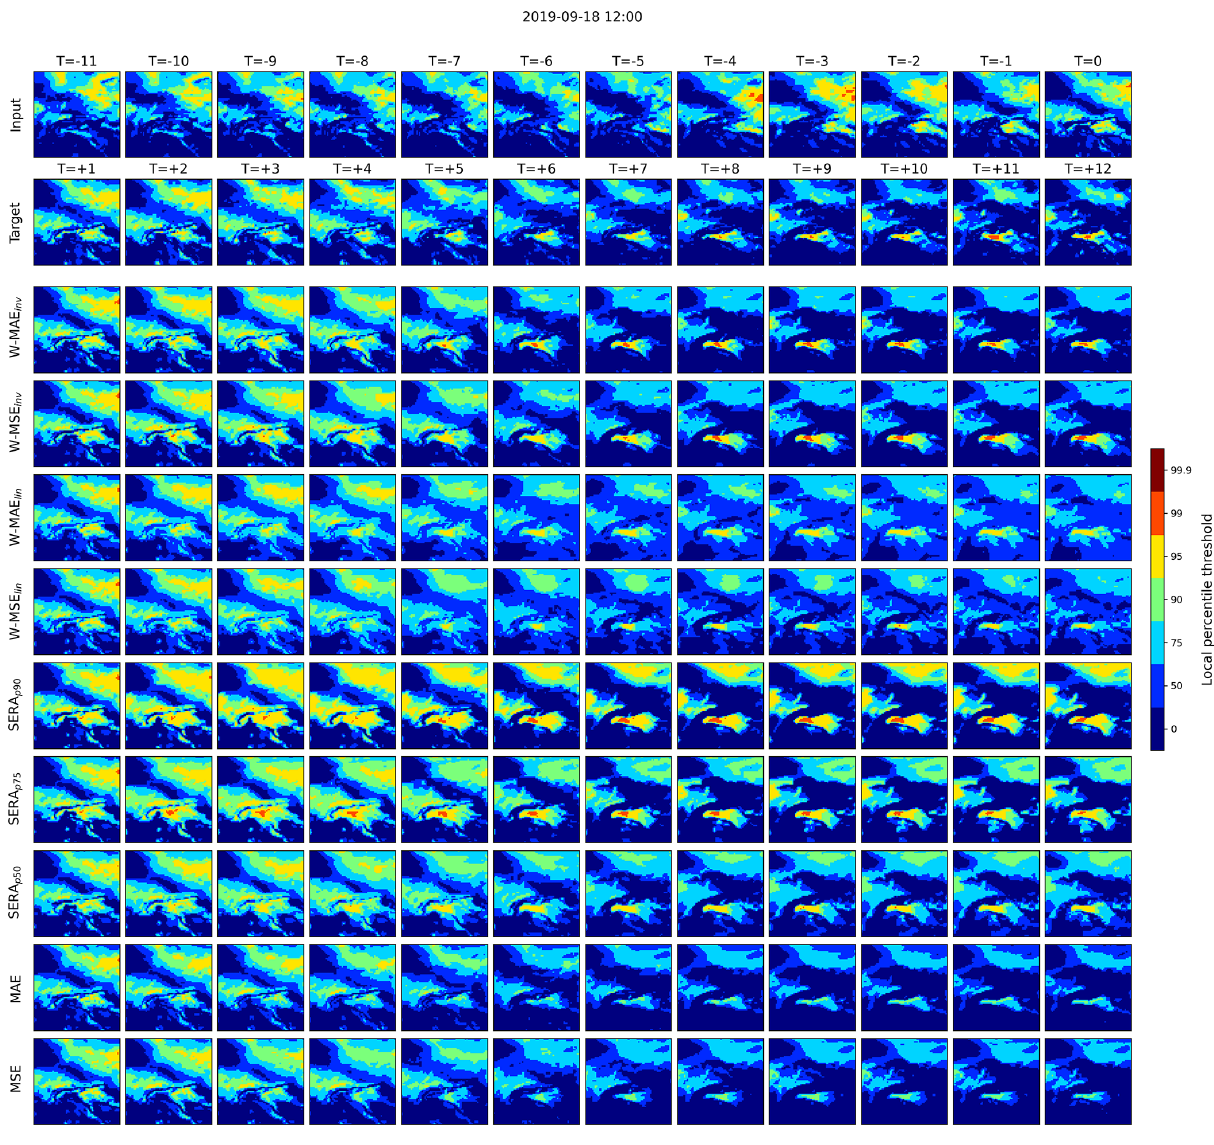
Figure 10. As Fig.